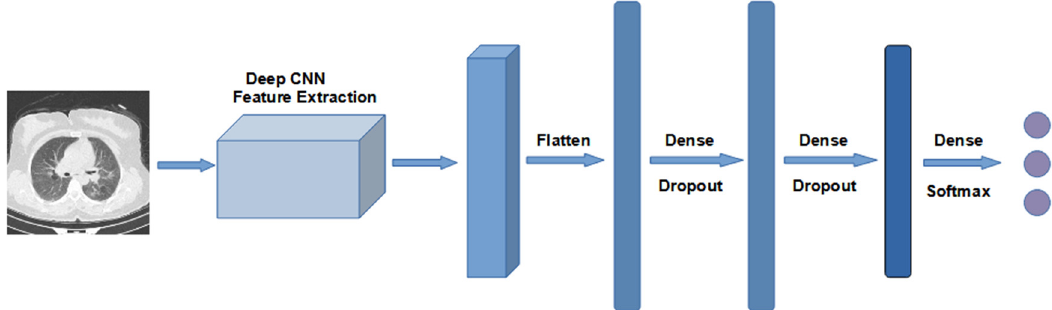
Figure 7. Training Deep CNN Models.